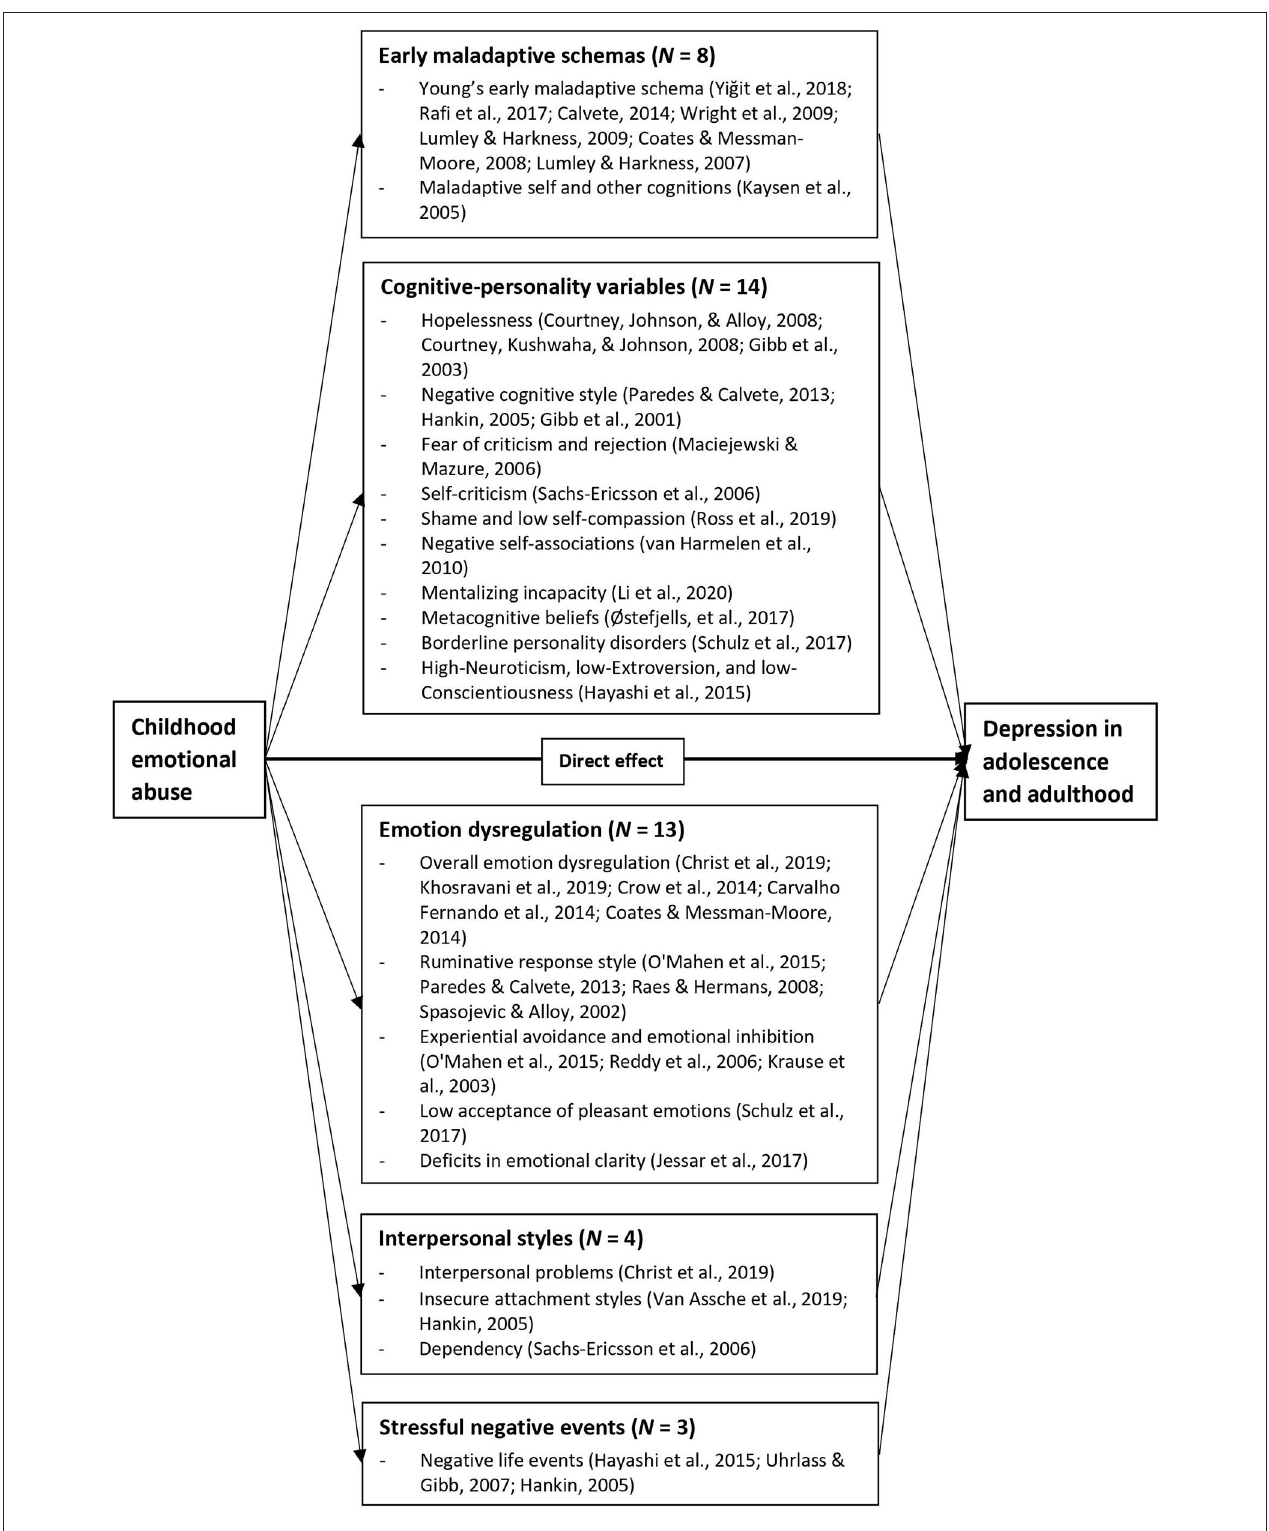
FIGURE 2 | Examined mediators in the emotional abuse–depression link.